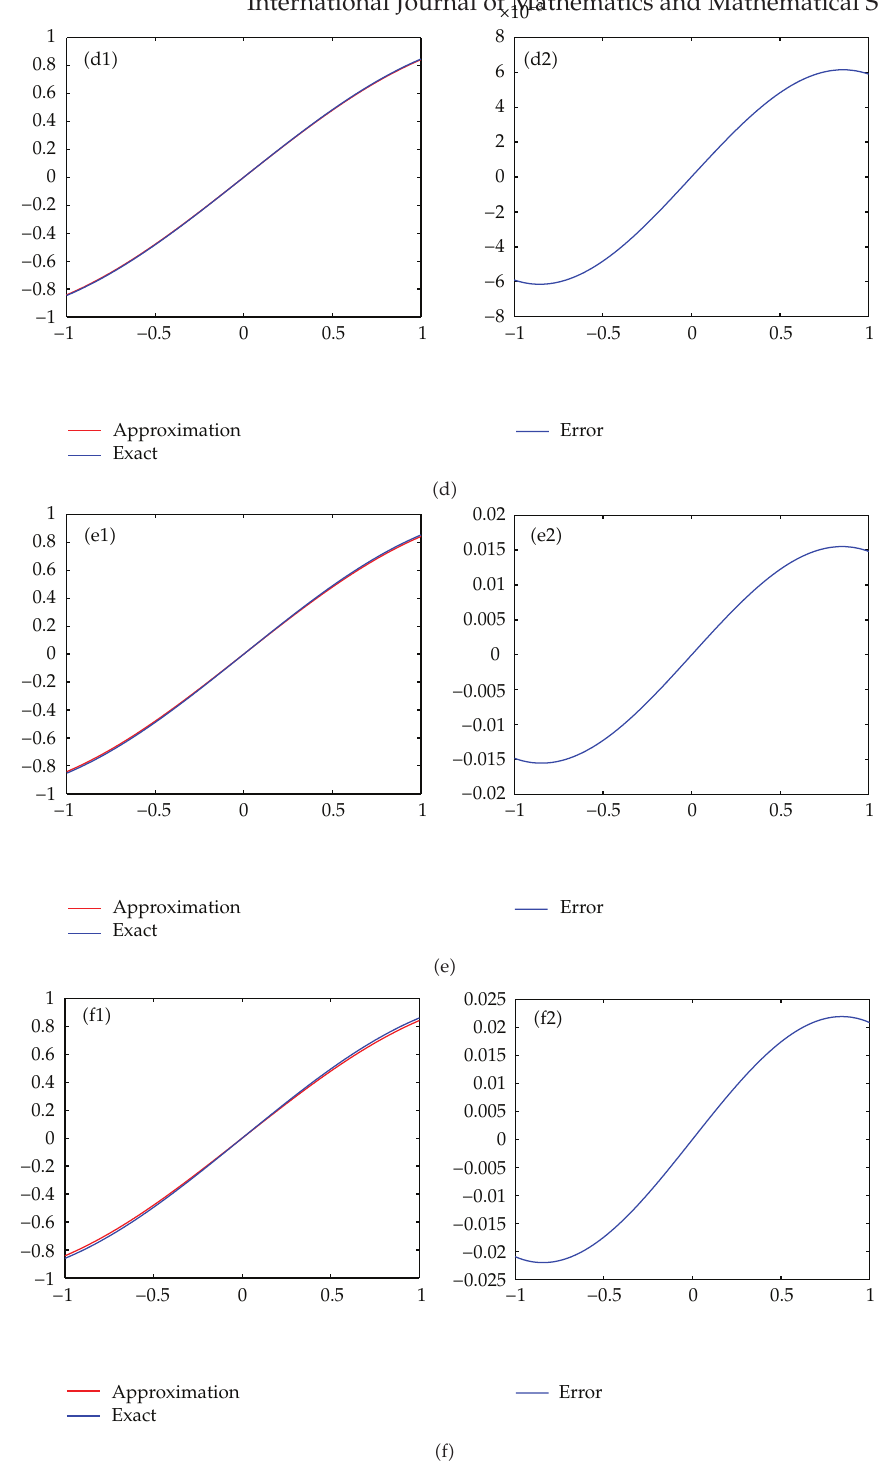
Figure 1: Numerical solution of our example for di ff erent values of α and β . (cid:3) a 1 (cid:4) α (cid:7) 0, β (cid:7) 0; (cid:3) a 2 (cid:4) is error. (cid:4) α (cid:7) − 0 . 4, β (cid:7) − 0 . 4; (cid:3) b (cid:3) b 1 (cid:3)